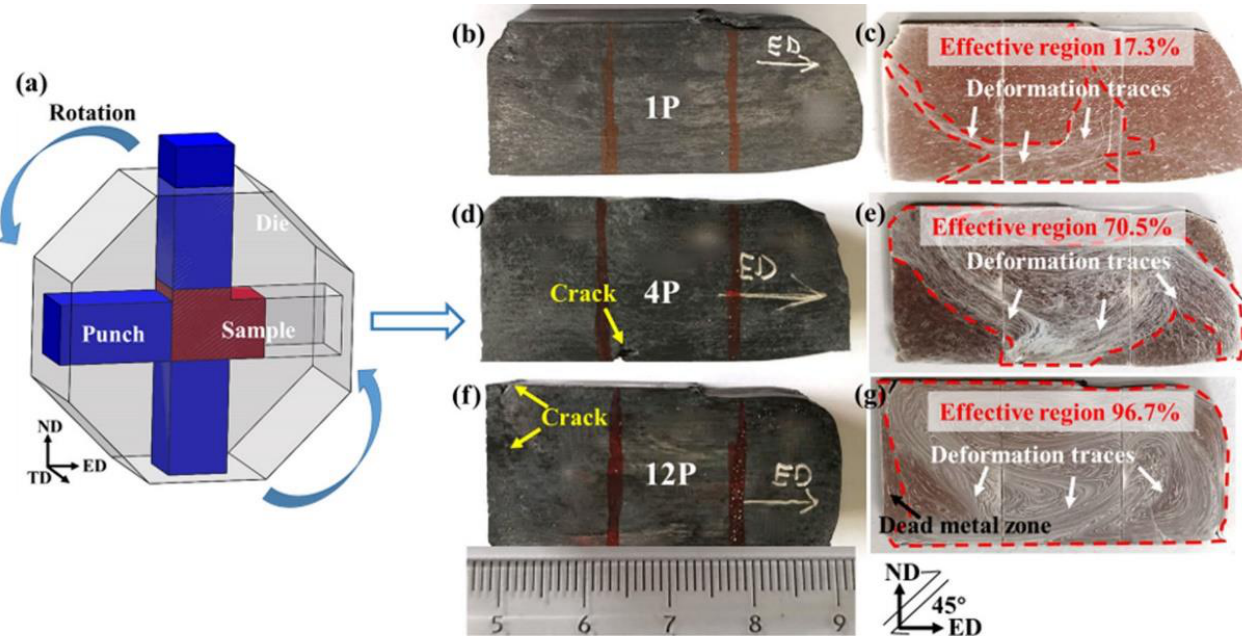
Figure 1. ( a ) Schematic of the RD-ECAP die ( b , d , f ), the macrographs of multi-pass RD-ECAP-processed sample, and ( c , e , g ) deformation traces revealed by metallographic corrosion, where the severe deformed zones were surrounded by red dotted lines.